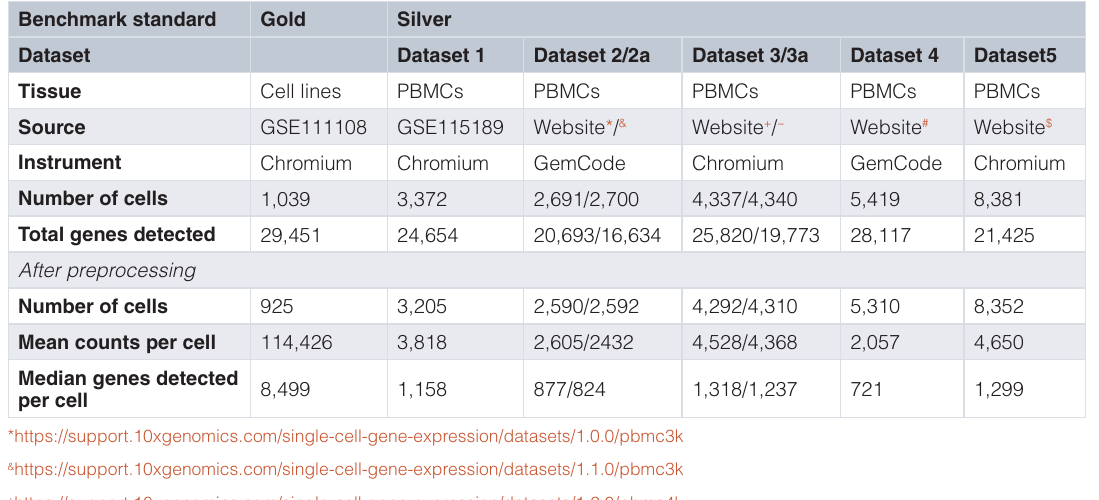
Table 2. Properties of all benchmarking datasets used in the study.